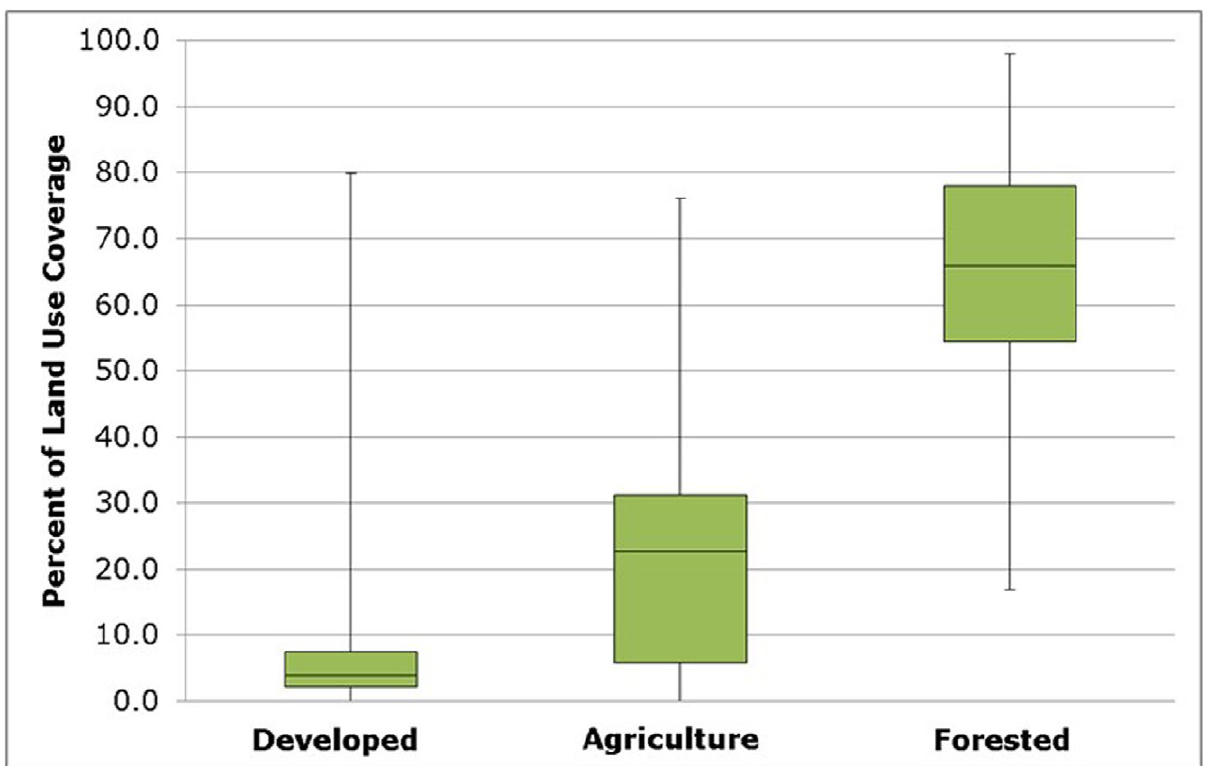
Figure 9: Box and whisker plot showing the distribution of the three major land uses within the 116 watersheds